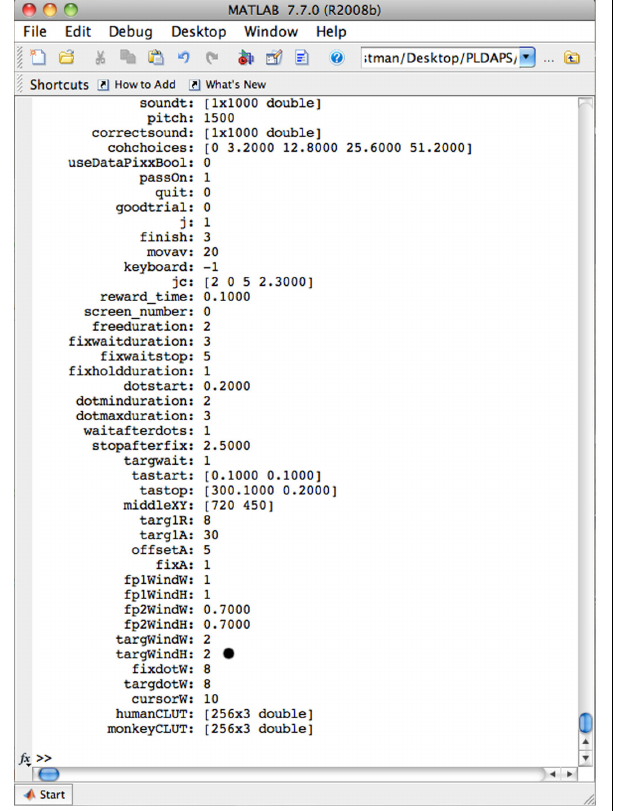
FIGURE 3 | Receptive Field Map. This graph shows the spatial selectivity (pre-saccade firing rate-base firing rate) of a neuron during each trial as a function of the target location. As the plot updates after each trial, it allows the experimenter another method of evaluating the size and shape of the neuron’s response field during the experiment. A threshold (black contour line) for calculating a center-of-mass for RF is movable with the slider button on the right hand side. Such interfaces can be developed and customized quickly according to the experimenter’s